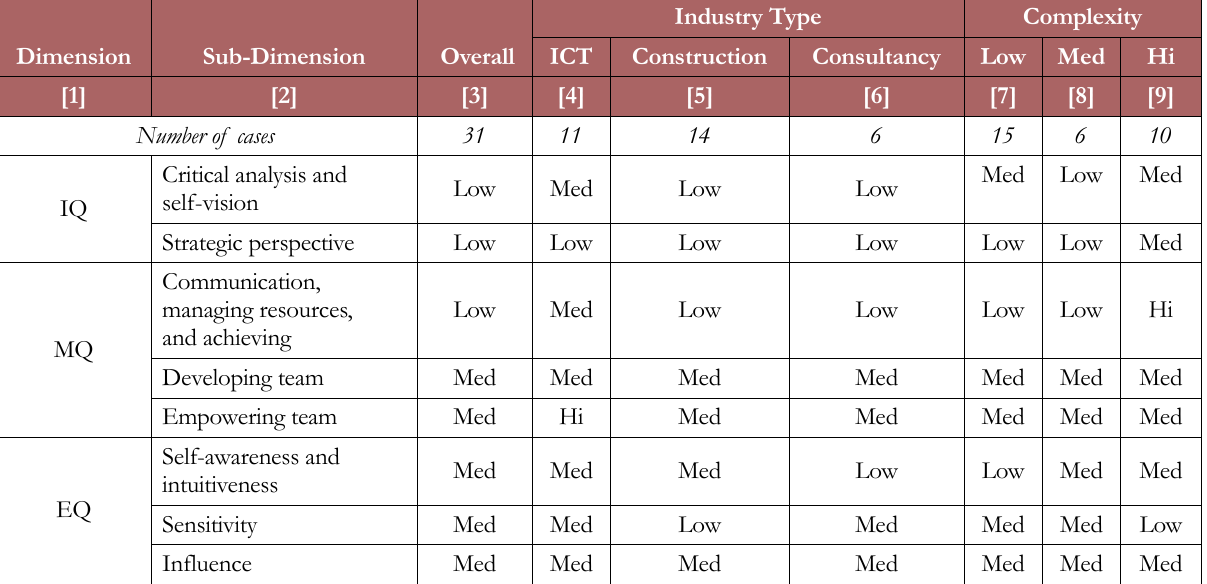
Note: Hi for high, Med for medium, Low for low level Table 7. The Leadership Competency Map for Less Successful Projects (Industry Type, Complexity as Moderating Variables)